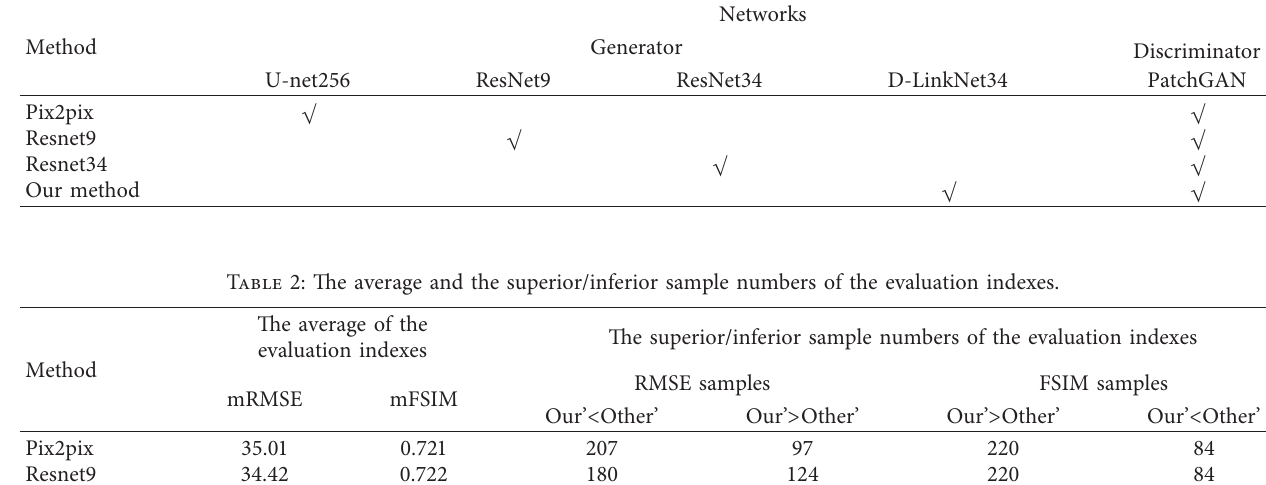
Table 1: The network structure of the four GANs algorithms.